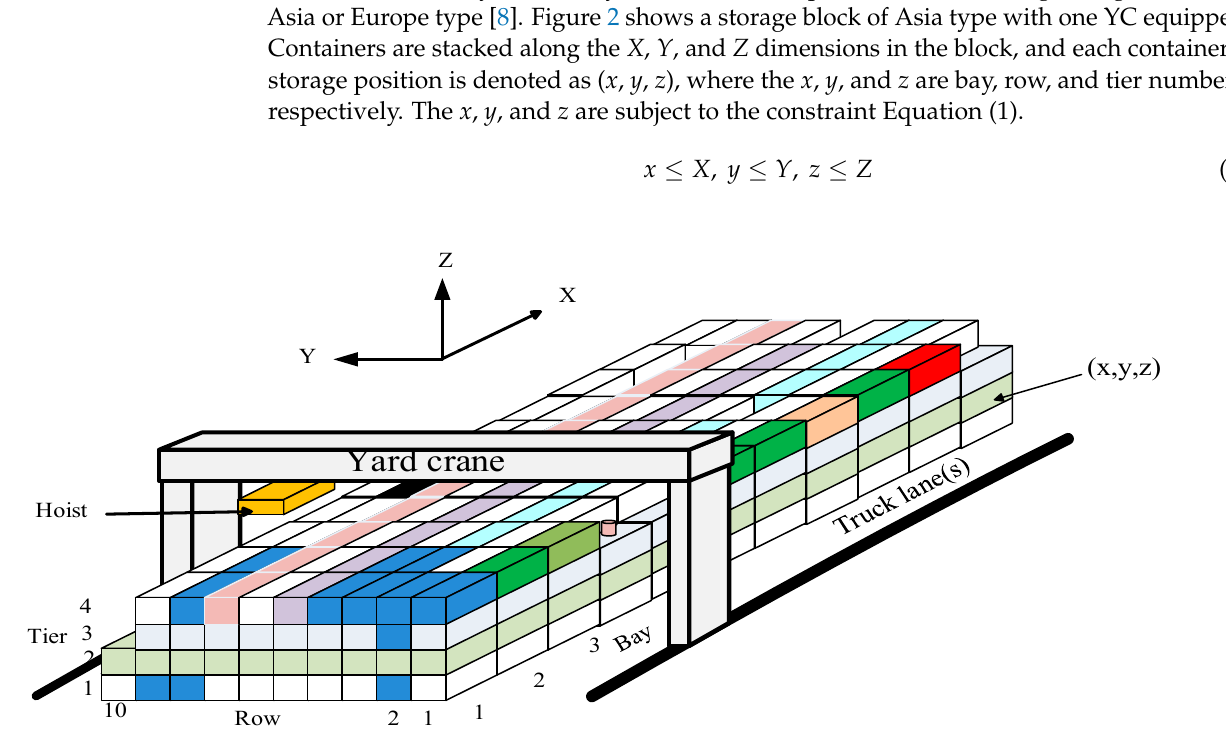
Figure 2. A storage block of Asia type with one rail mounted YC.